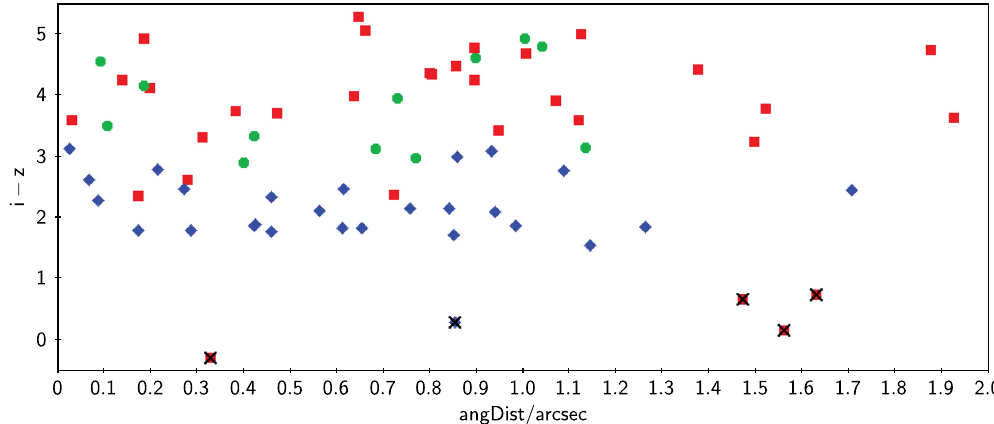
Figure 4: Results of the crossmatching the K2021 with SDSS DR12 with 2 arcsec crossmatching radius. Red squares are faint objects, green circles are transit objects, blue diamonds are bright objects. Crosses indicate suspicious